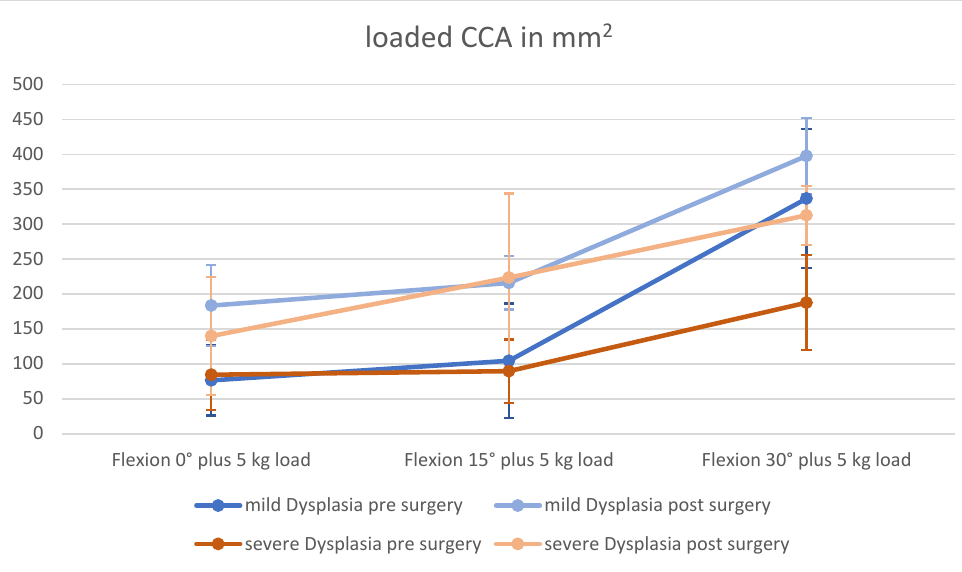
Figure 6. Changes in CCA with loading.